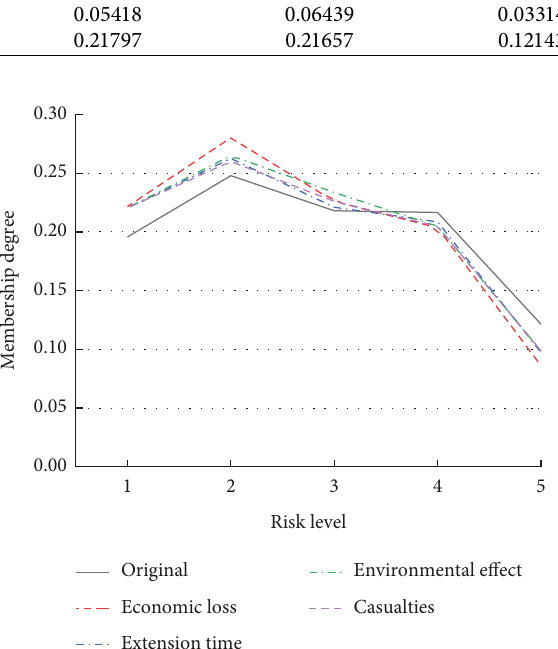
Figure 10: Effect of changes in the level of each loss indicator on the overall risk level in the case of consideration of loss indicator weights in uneven settlement of the foundation.